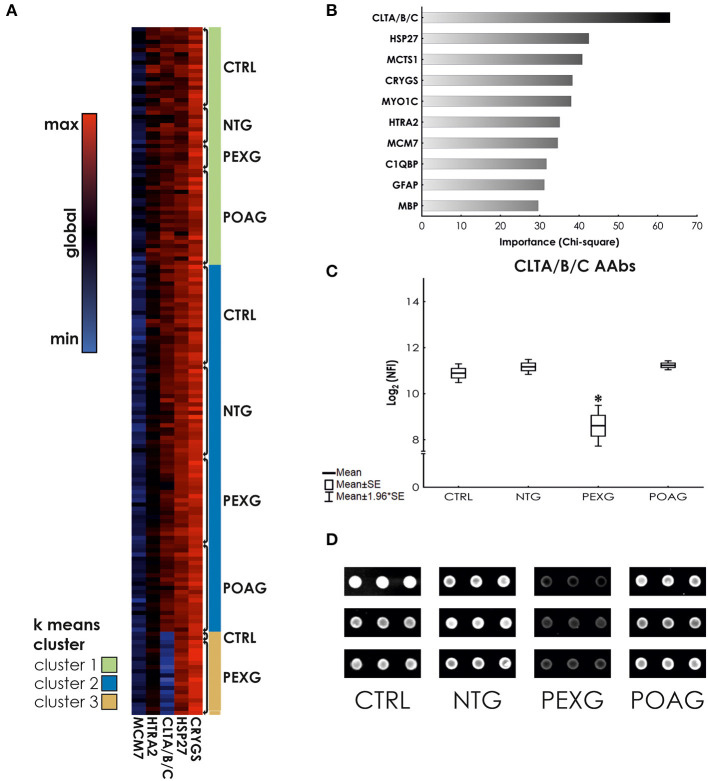
K means clustering and predictor screening. (A) Heat map showing autoantibody reactivities in glaucoma subtypes and control samples. (B) Predictor screening of autoantibody levels. The most important predictor for group affiliation are CLTA/B/C antibody levels. (C) ANOVA with HSD unequal N post-hoc test. CLTA/B/C autoantibody levels are significantly decreased in serum of PEXG patients compared to the other groups. (D) Representative examples of CLTA/B/C antibody reactivity on processed microarrays of individual samples. *Indicates statistical significance at P < 0.05.